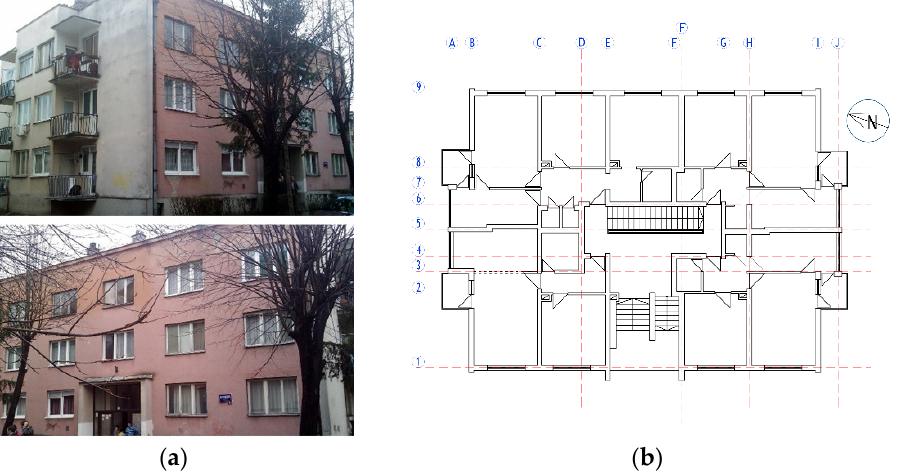
Figure 14. URM building located in Njegoševa Street No. 2, Kraljevo: ( a ) exterior views and ( b ) typical floor plan.